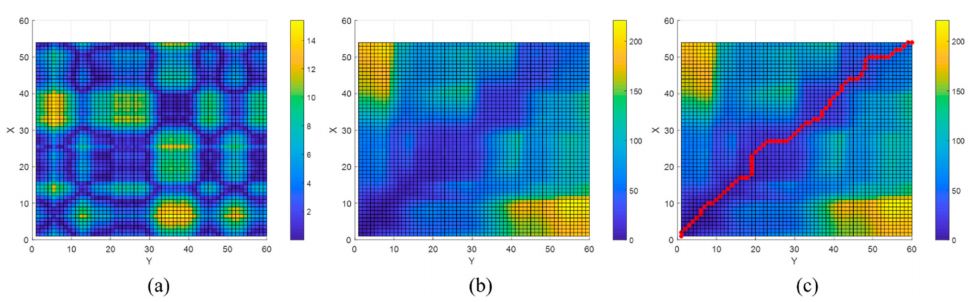
Figure 8. ( a ) Cost matrix; ( b ) Accumulated cost matrix; ( c ) Optimal path.